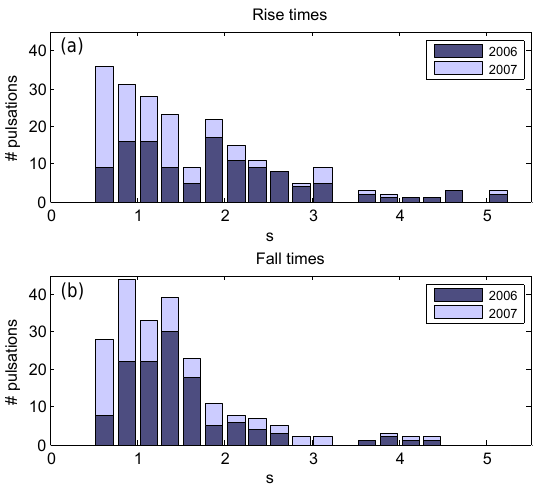
Figure 7. (a) Distribution of rise times for 219 pulsations detected during the two events. (b) Distribution of fall times for the same pulsations.